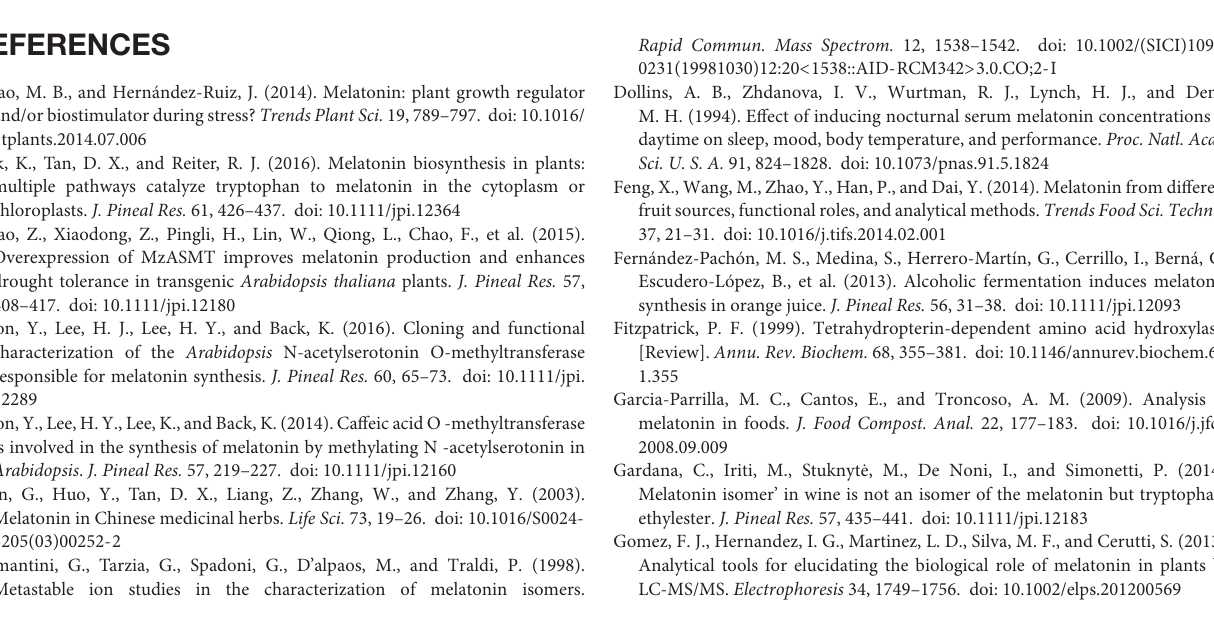
Melatonin and its isomers were measured using UPLC-MS/MS. 1, April 28th; 2, June 28th; 3, August 28th. Significant differences ( P < 0.05) are marked with different letters above the bars. Supplementary Figure 2 | Contents of melatonin and its isomers in mulberry leaves at different maturity stages from three varieties harvested during July, 2016. Melatonin and its isomers were measured using UPLC-MS/MS. 1, 1st leaves; 2, 5th leaves; 3, 10th leaves; 4, 15th leaves; 5, 20th leaves. Significant differences ( P < 0.05) are marked with different letters above the bars. Supplementary Figure 3 | Expressional analysis of ASMT genes in two tissues (leaf and fruit) of two mulberry varieties sampled in 2017. (A) The expression profiles of the MaASMT s in two tissues of two mulberry varieties. Sample names are shown above the heat maps. Color scale indicates the degree of expression: green, low expression; red, high expression. (B) Expressional analysis of MaASMT4 and MaASMT20 . JL-NO30 represents the “Jialing NO. 30” variety; ZS-5801 represents the “Zhongsang 5801” variety. Significant differences ( P < 0.01) are marked with different asterisks above the bars. Supplementary Figure 4 | Expression and activity analyses of MaASMT9 and MaASMT19 proteins. (A) Schematic diagram of the E. coli expression vector in pCold TF harboring genes of interest. (B) Purification of N-terminal His × 6-tagged MaASMT9 and MaASMT19 proteins. E. coli BL21 (DE3) cells harboring either pCold TF- MaASMT9 or pCold TF- MaASMT19 were incubated with IPTG for 8 h at 28 ◦ C. Lane 1: protein marker; lane 2: pCold TF (+ IPTG); lane 3: recombinant ( − IPTG) lane 4: recombinant (+ IPTG); lane 5: purified protein. Products of in vitro enzymatic reactions were detected by UPLC-MS/MS. “TF” is Trigger Factor, a prokaryotic ribosome-related molecular chaperone that facilitates the translation and folding of peptides. “ ∗ ” indicates the Trigger Factor. “ − IPTG” indicates no addition of 1 mM IPTG to the E. coli BL21 (DE3) culture, “+IPTG” indicates the addition of 1 mM IPTG to the E. coli BL21 (DE3) culture. Sequence data have been deposited with GeneBank (Accession NOs are MN937268 for MaASMT9 and MN937269 for MaASMT19). (C) melatonin standard; (D) melatonin isomer standard (MI-3); (E) Chromatogram of N -acetylserotonin catalyzed by MaASMT9; (F) Chromatogram of N -acetylserotonin catalyzed by MaASMT19. Supplementary Figure 5 | Sequence analysis of ASMT proteins in plants. The alignment was performed using GeneDoc and the positions of the different conserved domains are represented by different colored boxes. The conserved motif for the S -adenosine- L -methionine binding are boxed in red, putative substrate-binding residues are boxed in black, and catalytic residues is boxed in